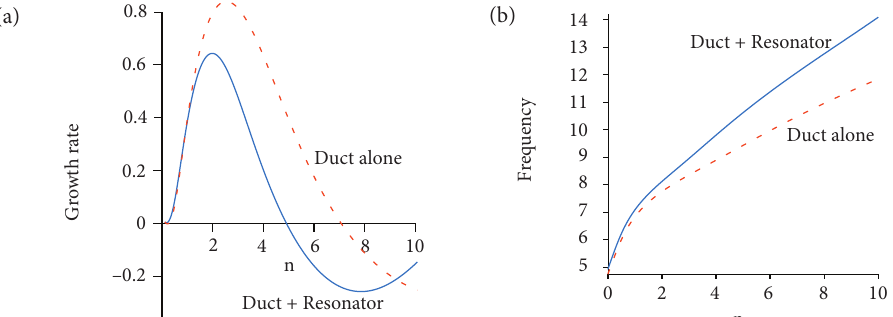
= 0.10, V = 0.2, ω = 2, x = 0.5) f h h